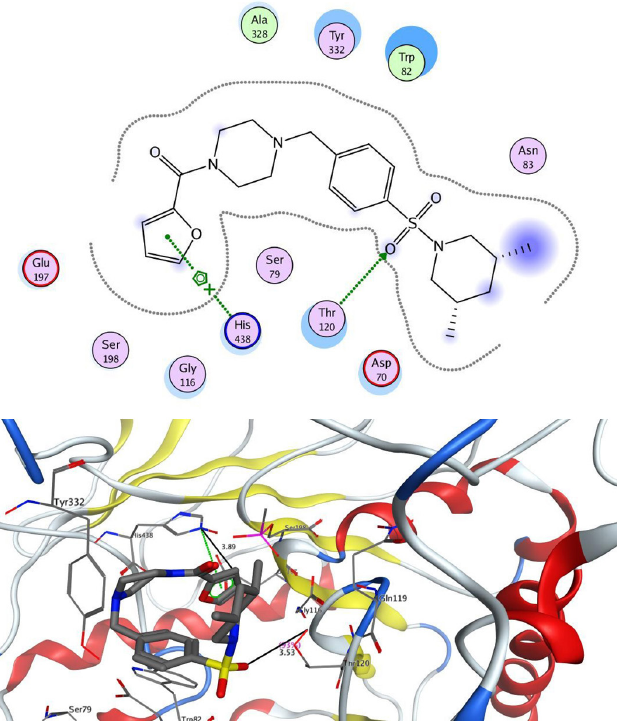
FIGURE 4 - The 2D and 3D interaction analysis of 4-{4-[(3,5-dimethyl-1-piperidinyl)sulfonyl] benzyl}-1-piperazinyl)(2-furyl)methanone ( 5h ) against butrylcholinesterase. FIGURE 5 - The 2D and 3D interaction analysis of 2-furyl(4- {4-[(3-methyl-1-piperidinyl)sulfonyl]benzyl}-1-piperazinyl) methanone ( 5e ) with